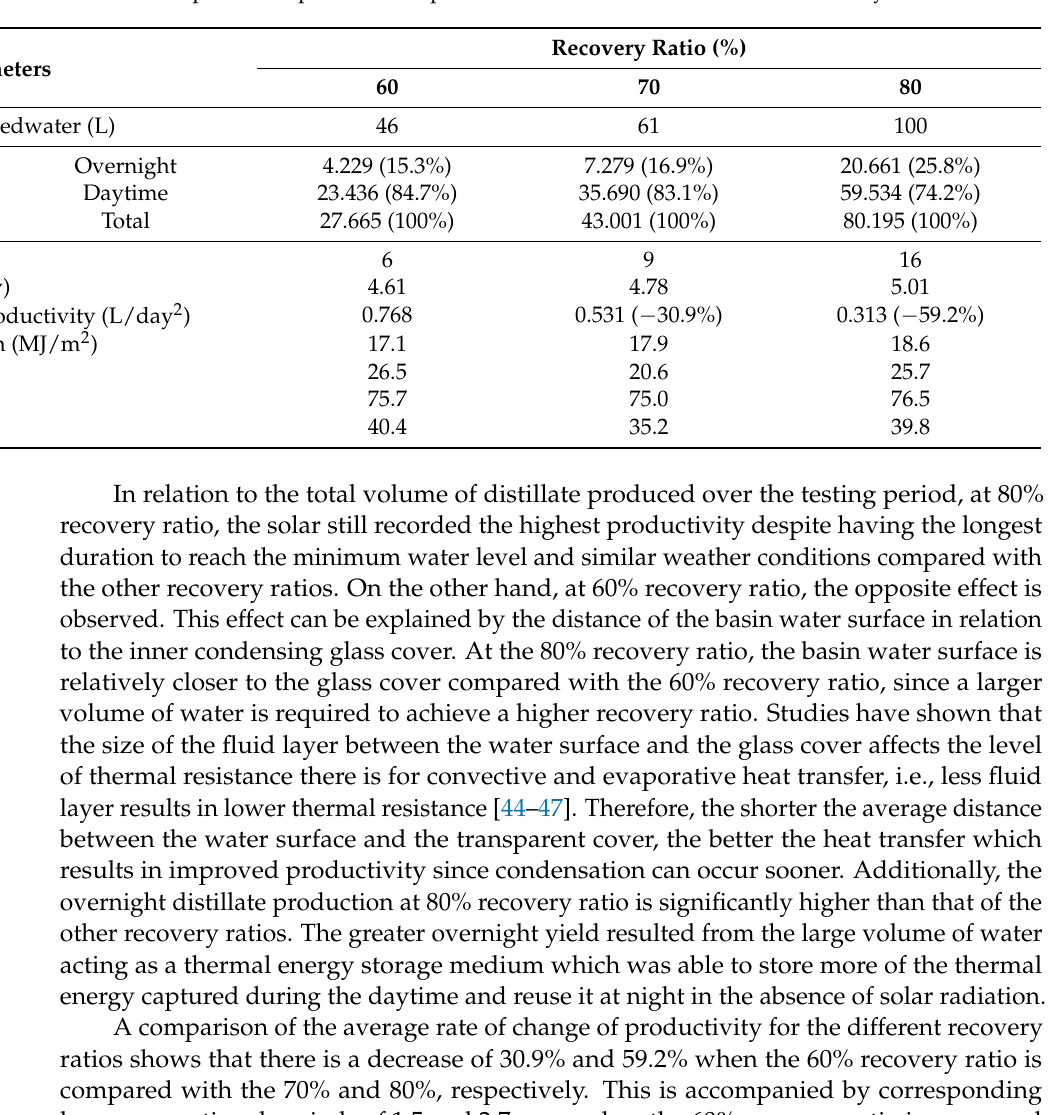
Table 4. Comparison of performance parameters of the solar still based on recovery